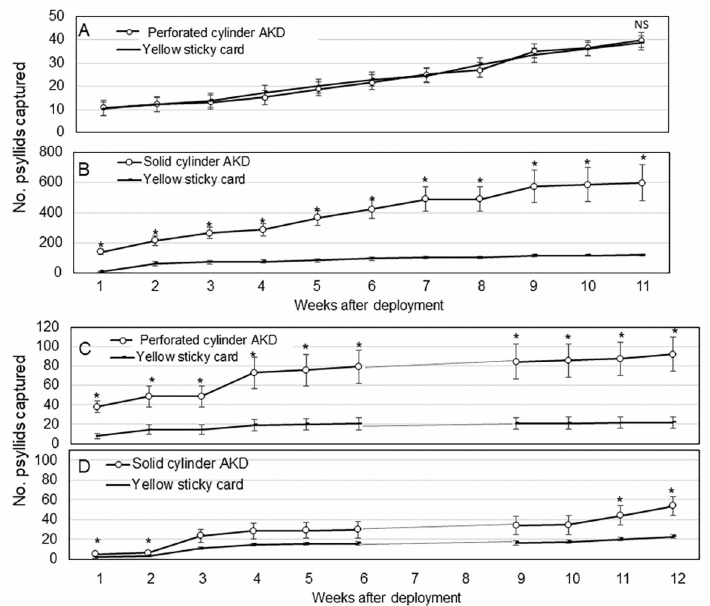
Figure 4. ( A ) Mean ( ± SEM, n = 6) cumulative number of D. citri adults captured by perforated cylinder AK device over 11 weeks in young citrus trees. ( B ) Mean ( ± SEM, n = 6) cumulative number of Diaphorina citri adults captured by solid cylinder AK devices over 11 weeks in mature citrus trees. ( C ) Mean ( ± SEM, n = 6) cumulative number of D. citri adults captured by perforated cylinder AK device during 12 weeks in mature citrus trees. ( D ) Mean ( ± SEM, n = 6) cumulative number of D. citri adults captured by solid cylinder AK device over weeks 12 weeks in young citrus trees. Data were not collected on weeks 7 and 8 due to hurricane Dorian. Means labelled with asterisks are significantly greater than their paired sticky card traps by paired t- test ( α = 0.05).